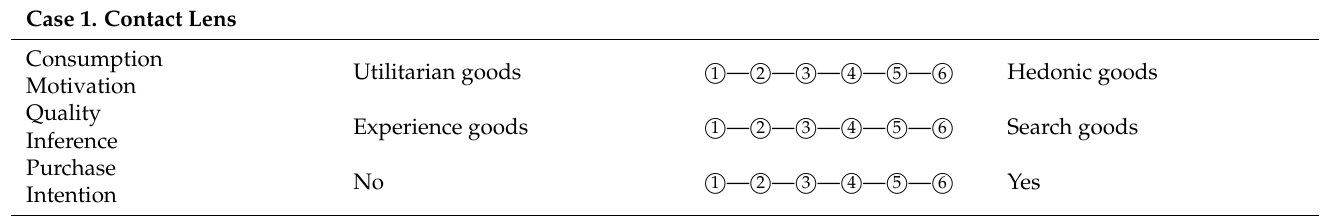
Table 2. Example of survey items (before introduction of subscription model).